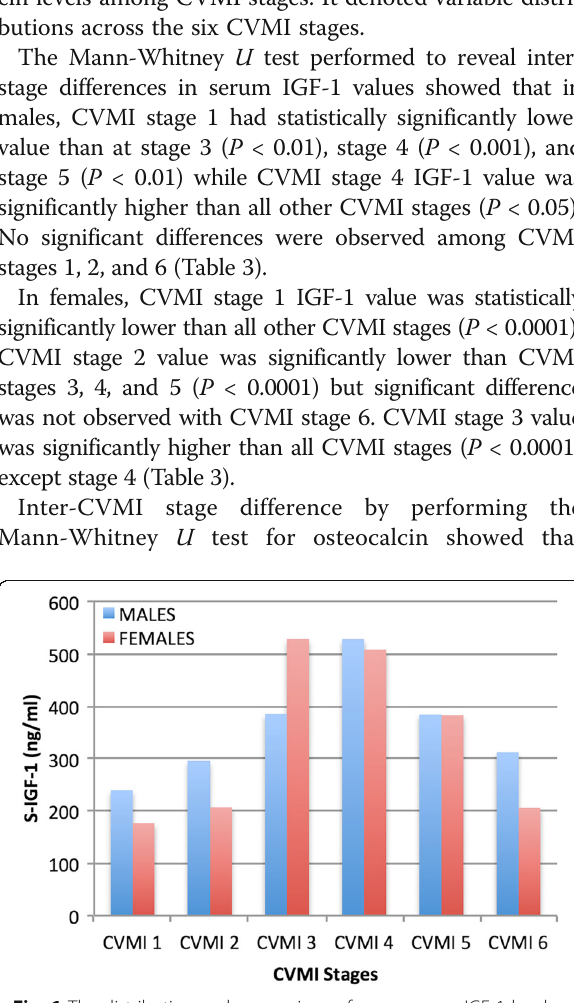
Fig. 1 The distribution and comparison of mean serum IGF-1 levels in males and females in the six CVMI